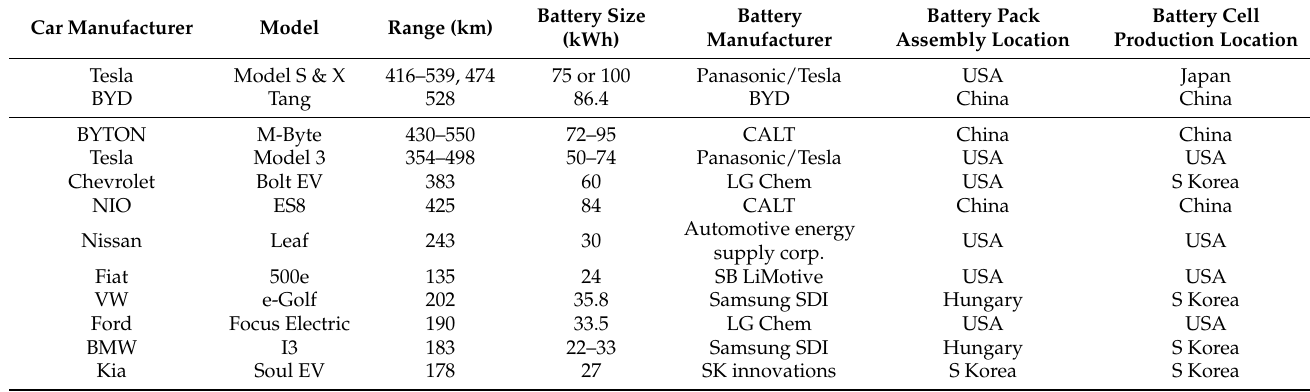
Table 1. Major electric car manufacturers and models, showing range, battery size, battery manu-